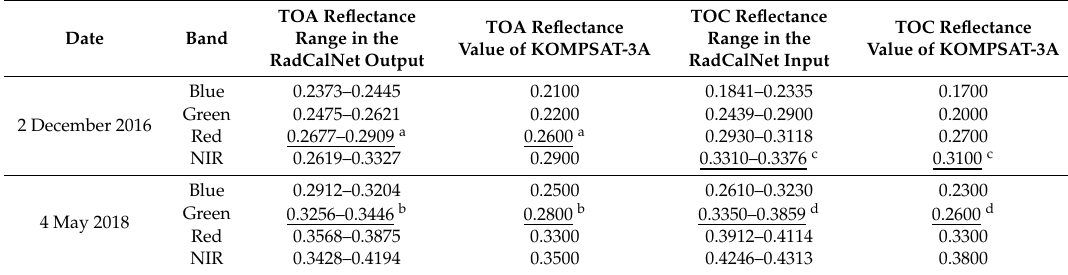
Table 1. KOMPSAT-3A TOA and TOC reflectance products and RadCalNet data from the RVUS